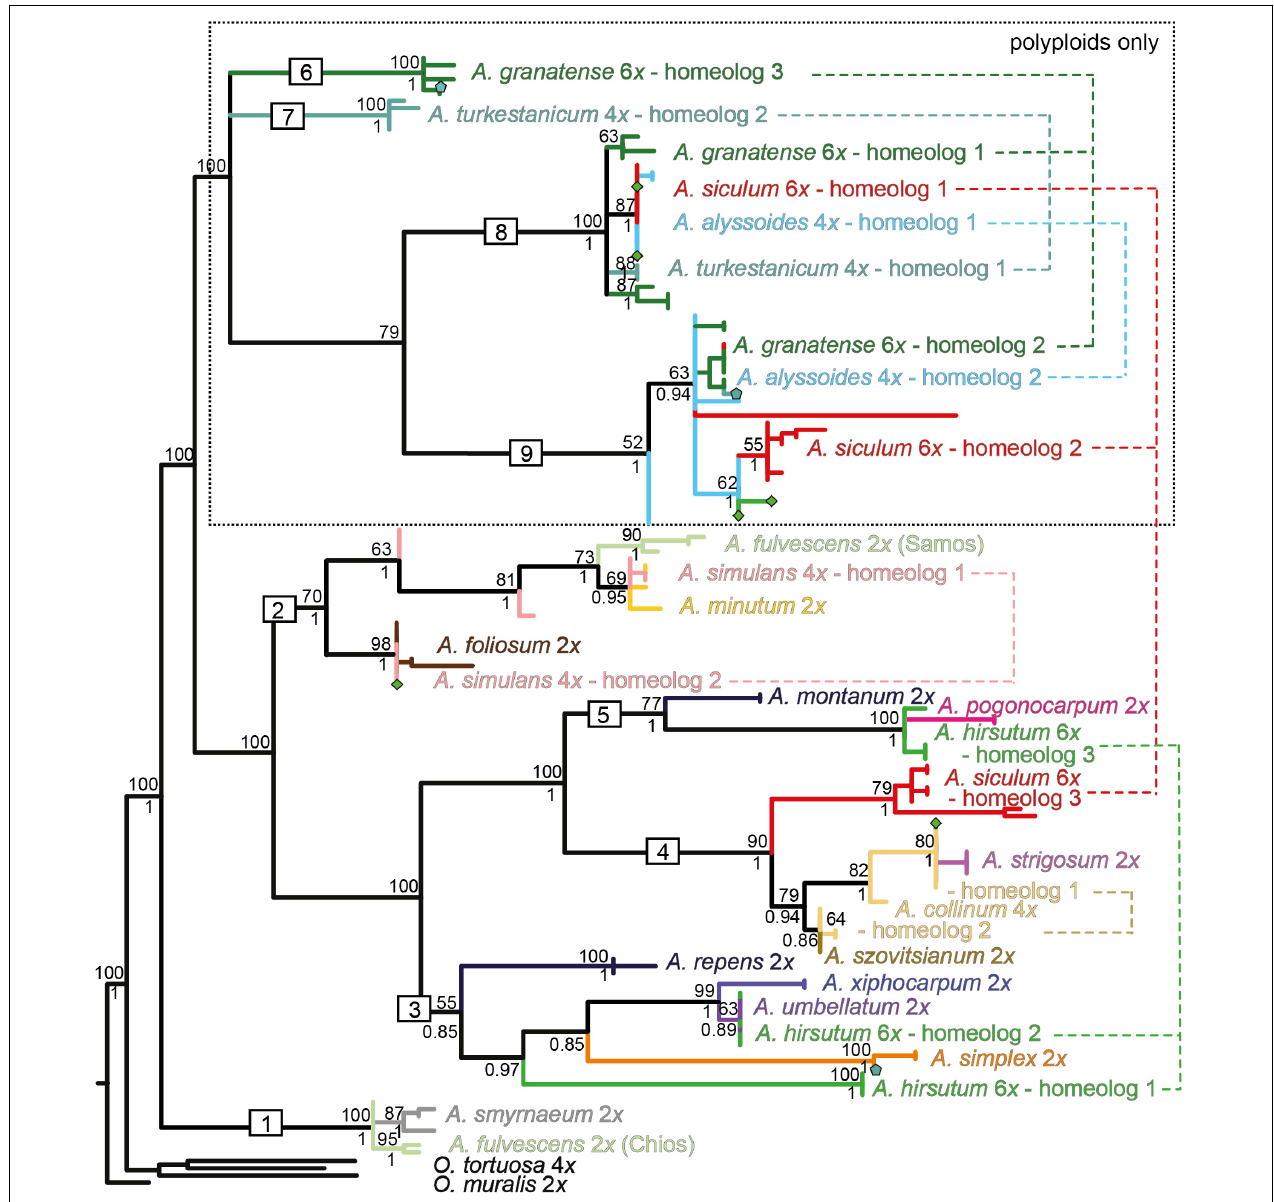
FIGURE 6 | Maximum-likelihood tree based on the DET1 sequence data for the studied Alyssum species. For the tree description, see the legend of Figure 4 . The different homeologs identified in the polyploid species are numbered and connected by dashed lines. Symbols (pentagons and diamonds) show the alleles that deviated from the observed homeolog variation in A. turkestanicum and A. hirsutum , respectively. The fully labeled version of the tree is shown in Supplementary Figure 3A